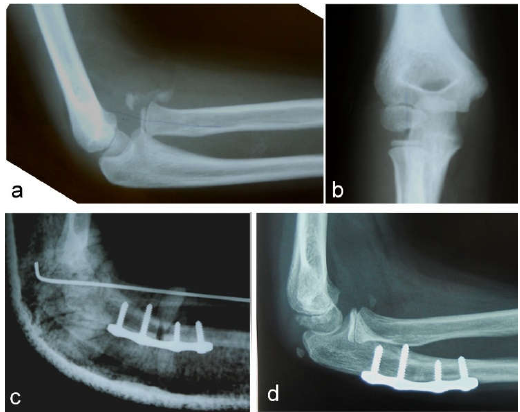
Figure 1. Neglected Monteggia fracture: ( a ) anterior dislocation of the radial head with heterotopic ossification visible on a lateral view; ( b ) AP view; ( c ) high posterior angulation and elongation osteotomy of the ulna stabilized with a plate and four screws. Transcapitellar fixation of the radial head with Kirschner wire; ( d ) the reduced radial head and healed ulnar osteotomy are visible on a lateral X-ray before removal of the plate and screws.